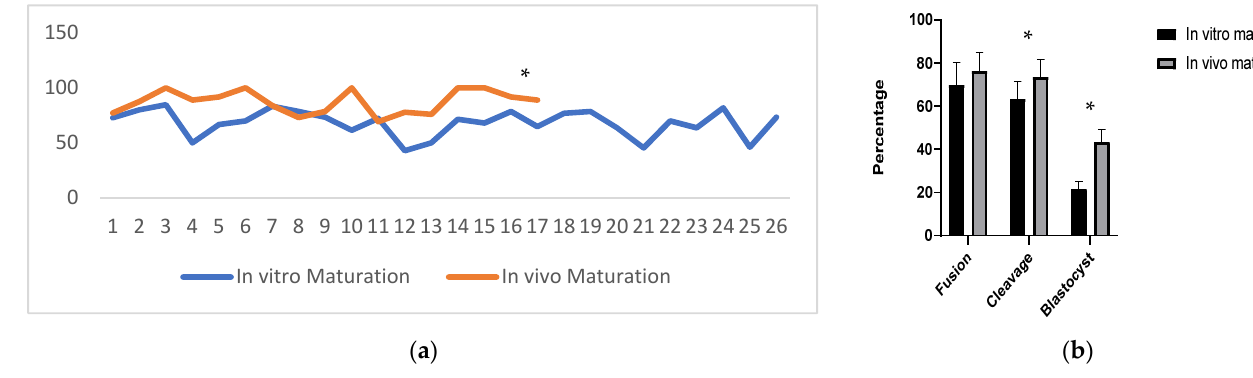
Figure 1. ( a ). In vivo and in vitro maturation rate of camel oocytes. ( b ) Developmental rate of SCNT-derived camel embryos using in vitro and in vivo matured oocytes, *in the same group indicates a significant difference ( p < 0.05).